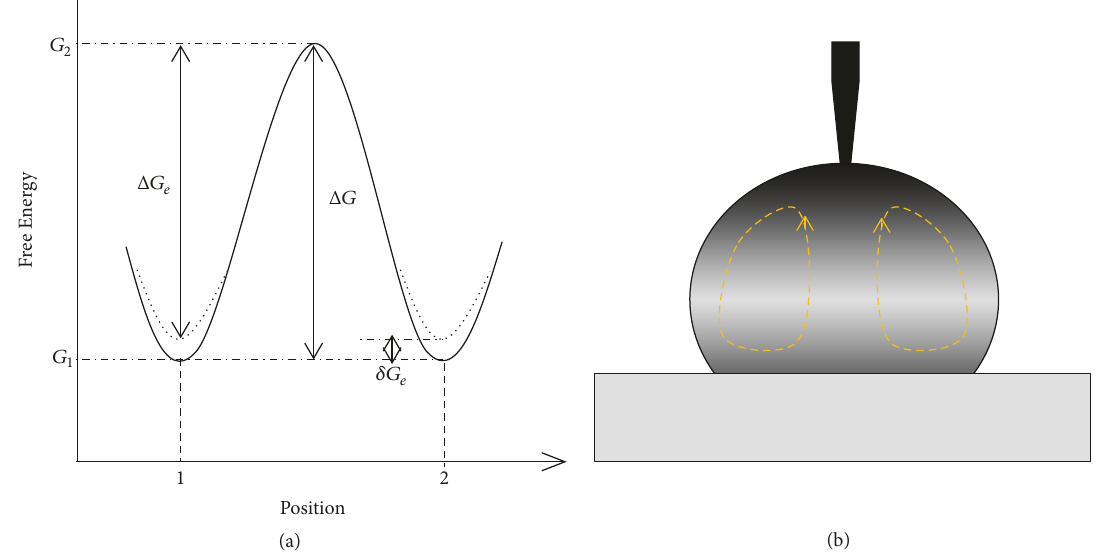
Figure 6: (a) Schematic explanation for the effect of DC on the diffusion activation energy. (b) Schematic of Marangoni convection in the Ga–In–Sn/Cu system under